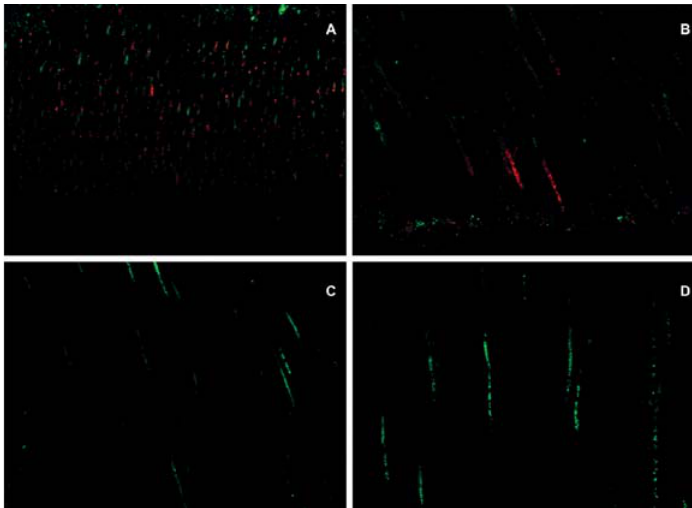
Figure 2- Confocal laser scanning microscopy (CLSM) images following contamination with E. faecalis . A- Longitudinal view of the medial third of a root canal following group A contamination. Low level penetration of bacteria inside the tubules can be observed. Red color denotes dead bacteria; B- Longitudinal view of the cervical third of a root canal following group A contamination. Compared to Figure 2A, there are slightly more bacteria inside the tubules and some of them are green, denoting live bacteria; C- Longitudinal view of the cervical third of a root canal following group B contamination. A small amount of live bacteria can be observed; D- Longitudinal view of the medial third of the root canal following group B